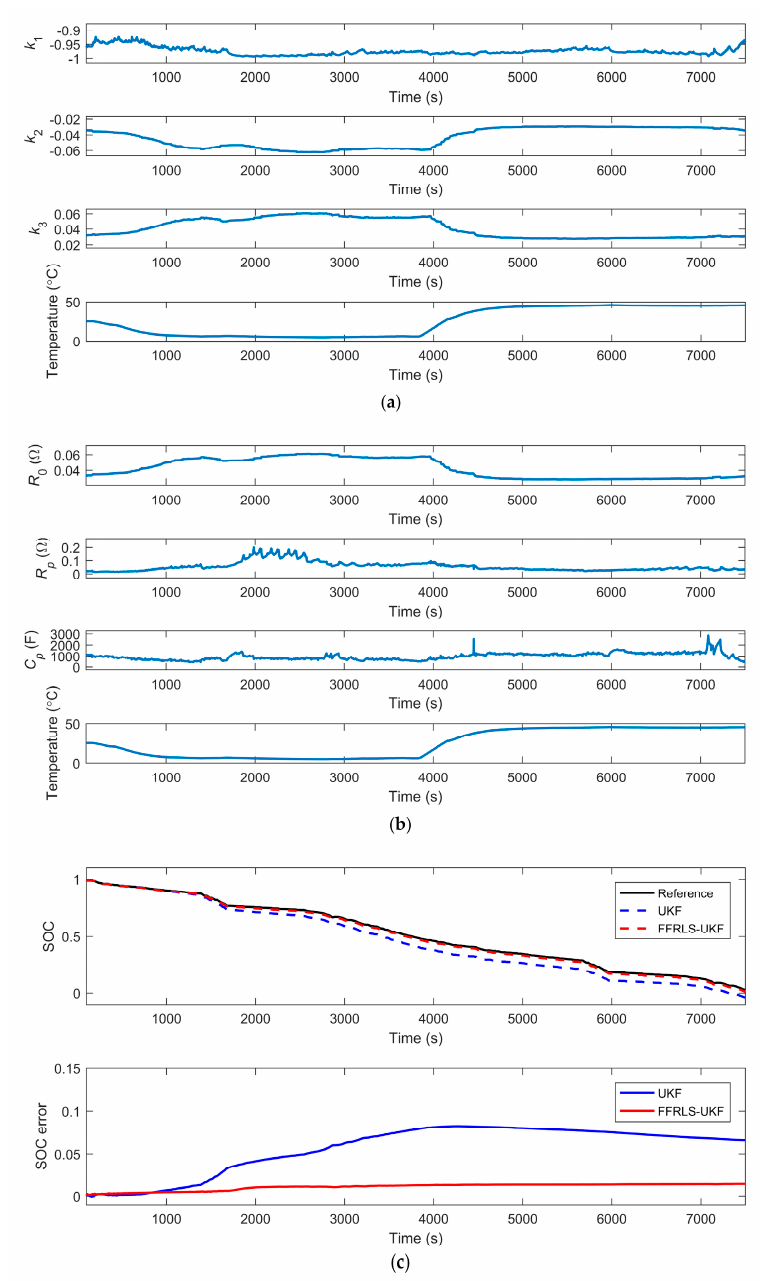
Figure 9. Calculation results of UKF and FFRLS-UKF without measurement noise: ( a ) Identification of k 1 , k 2 and k 3 ; ( b ) Identification of R 0 , R p and C p ; ( c ) SOC estimation results of UKF and FFRLS-UKF.